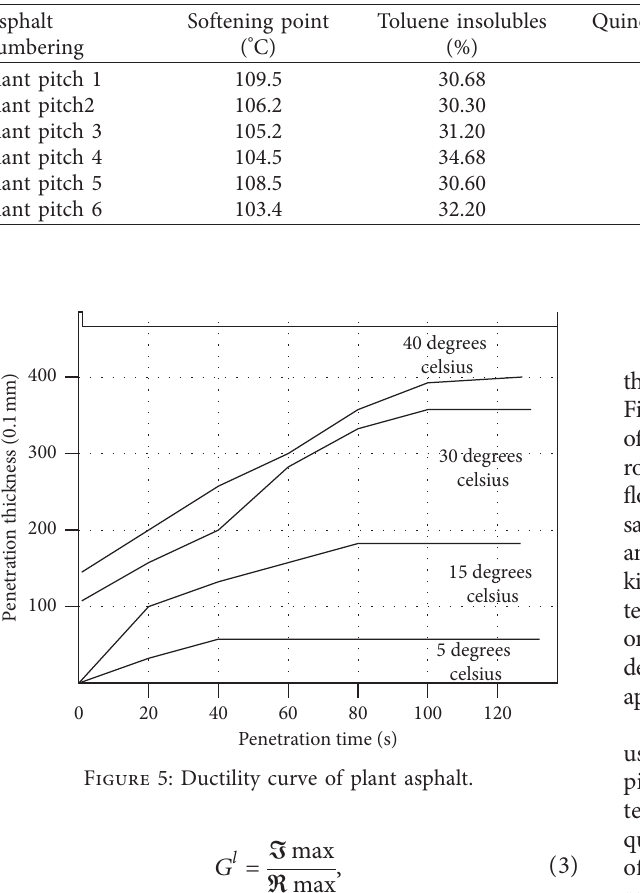
Table 2: Performance analysis index of plant asphalt.